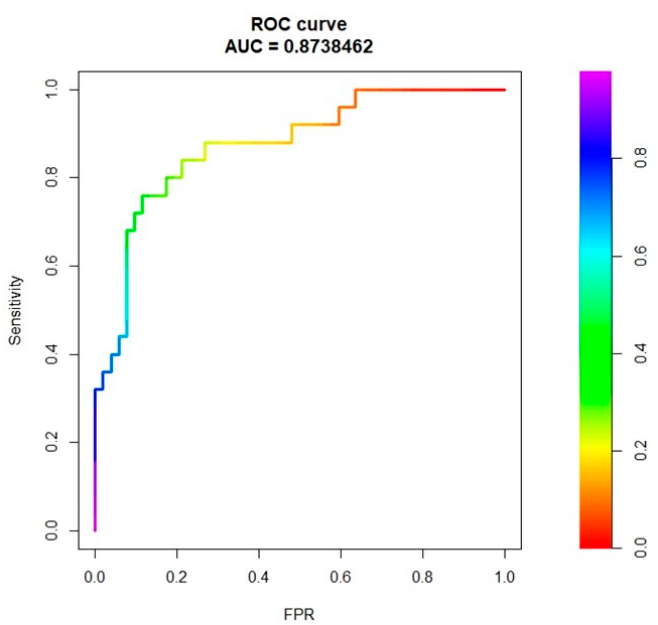
Figure 1. ROC curve analysis referring to the prediction of sinusoidal dilatation (grade 0–1 vs. grade 2–3), considering clinical, laboratory, and radiomic variables for model training.